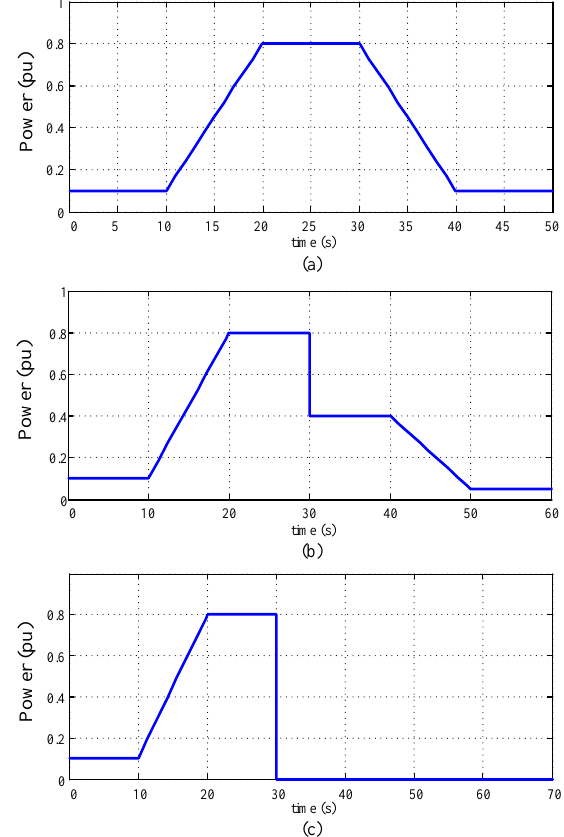
Figure 7. The operating conditions: ( a ) Acceleration and deceleration; ( b ) Loss of prime mover trip; ( c ) Full propulsion load rejection.